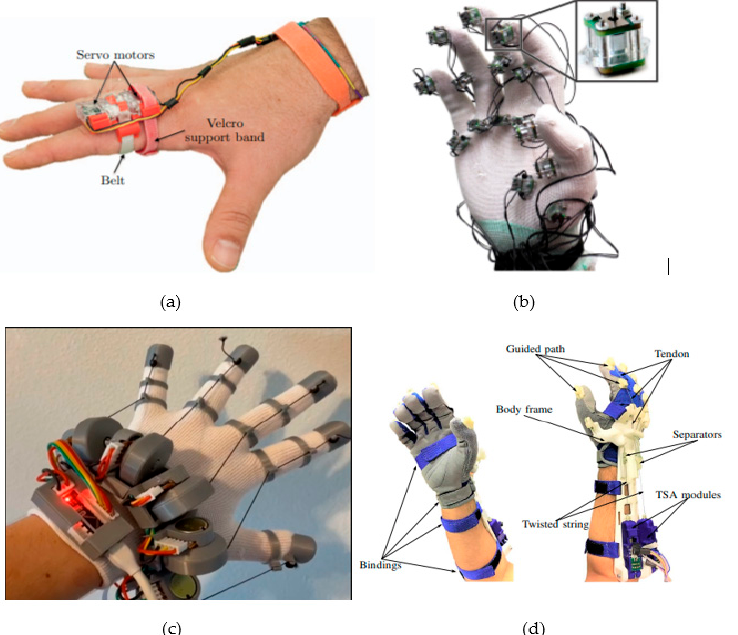
Figure 1. An example of both cutaneous and kinesthetic feedback devices that show the ( a ) hRing which utilizes skin stretch, reprinted with permission from [75], ( b ) TacTiles which utilize electromagnetic brakes for applying pressure, reprinted with permission from [76], ( c ) LucidVR, string-based actuators, retrieved from [77], and ( d ) ExoTen which utilize McKibben-based artificial muscles, reprinted with permission from [78] .